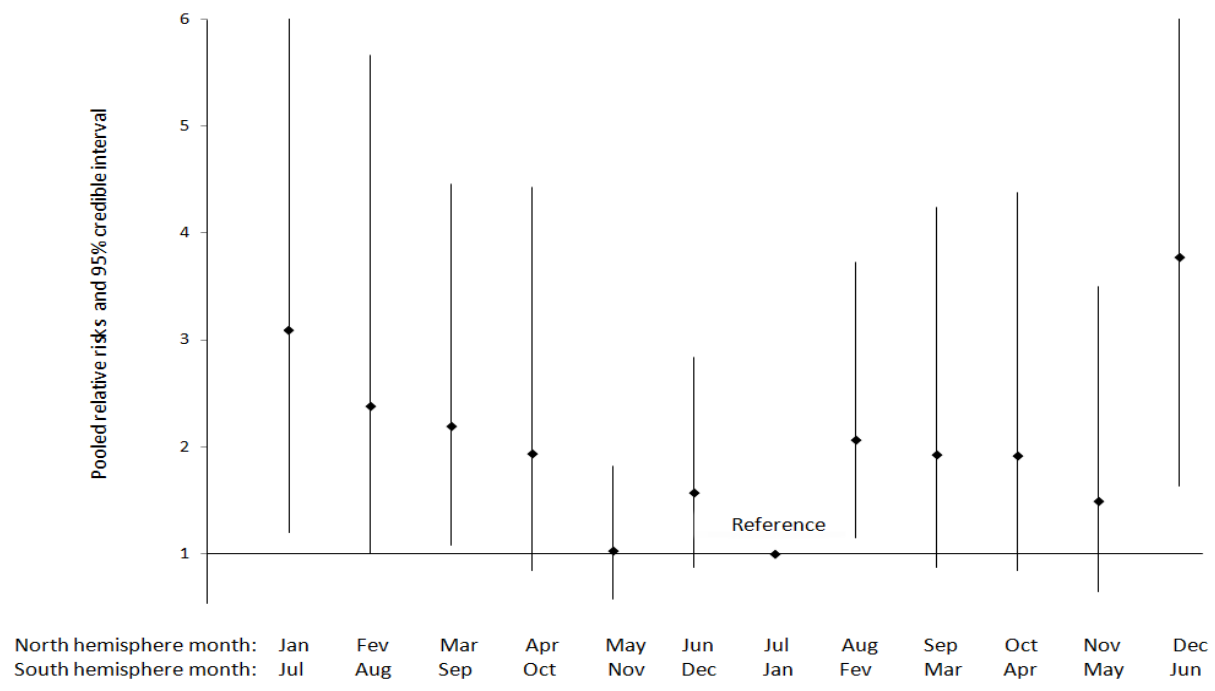
Figure 3. Pooled relative risks and 95% credible interval for the variation in eclampsia incidence by month of birth ( N = 550,881